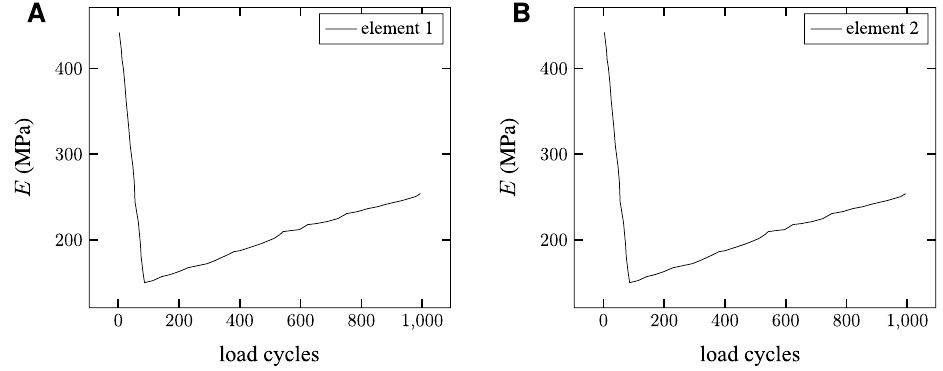
Fig. 8. Evolution of Young’s modulus for element 1 (A) and element 2 (B) along the load